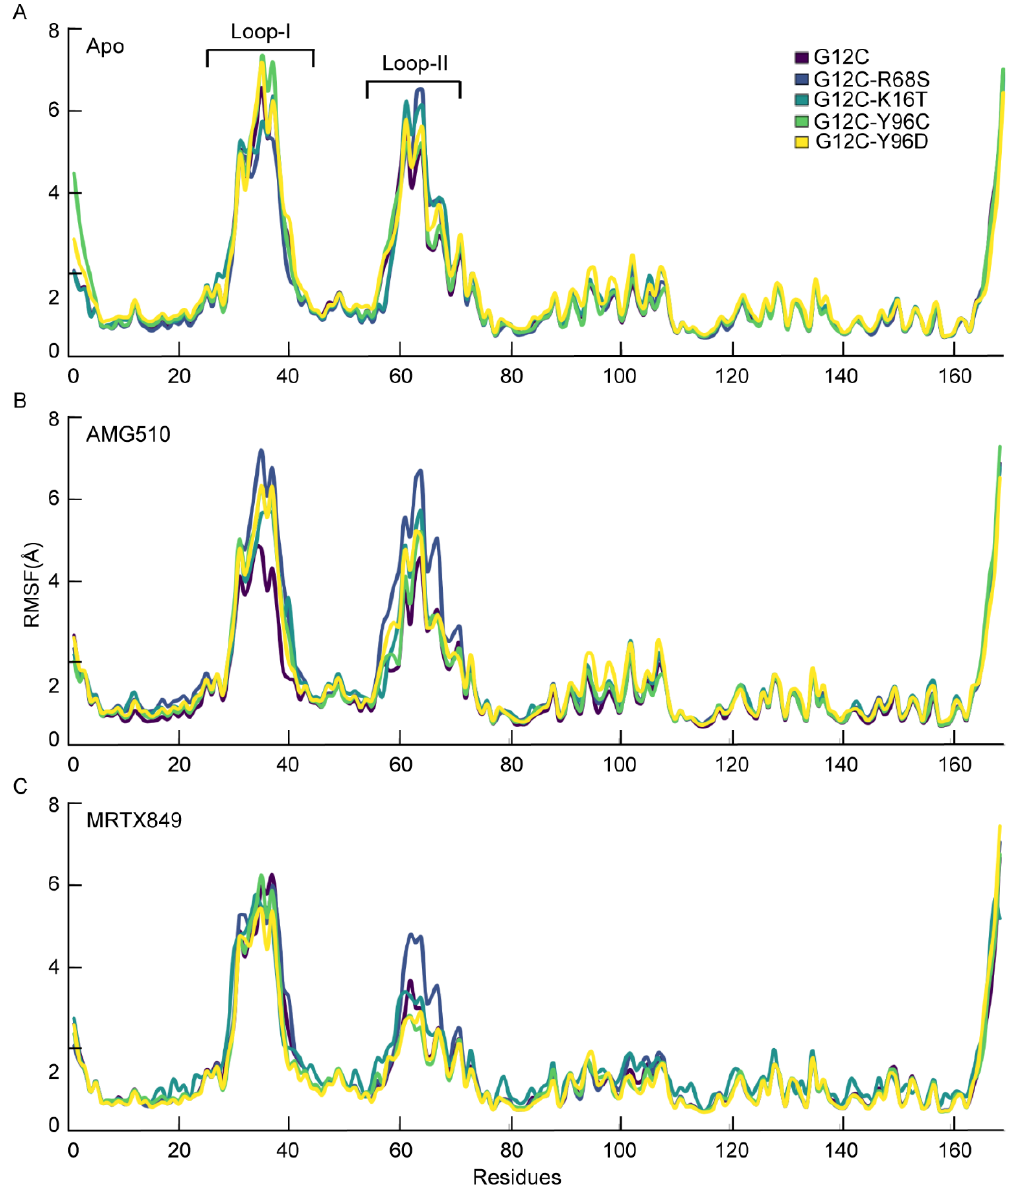
Figure 7. ( A ) The RMSF values (Å ) of residues in apo KRAS G12C and four mutated systems. ( B , C ) The backbone RMSF values (Å ) of residues in AMG510/MRTX849 bound G12C complexes and AMG510/MRTX849 bound mutant complexes.